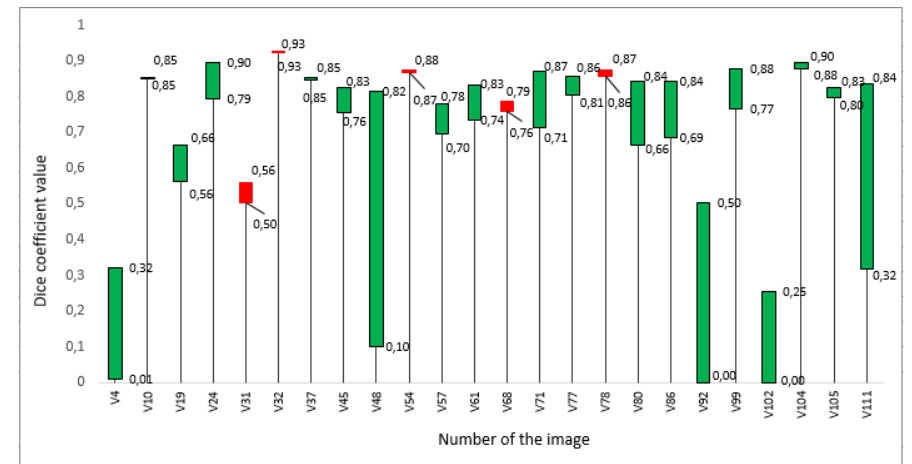
Figure 4. Dice coefficients estimated separately for individual H&E-stained images in the testing dataset: green bars show a gain in value, while red bars show a